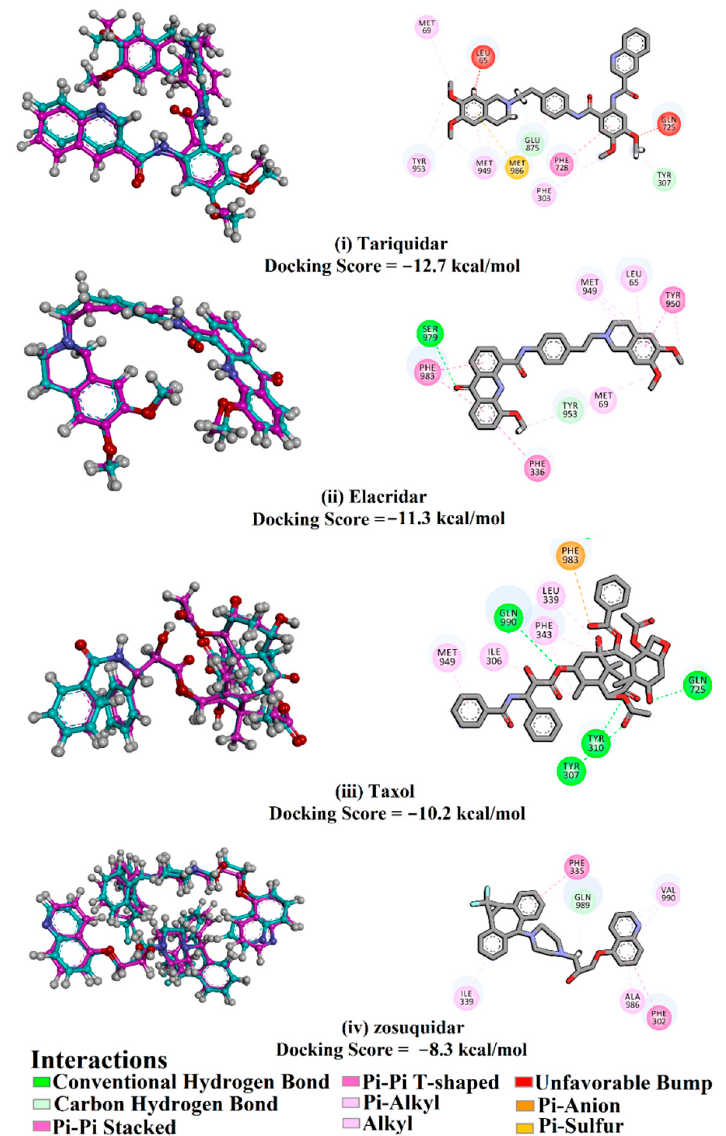
Figure 1. 3D and 2D molecular interactions of the experimental structures (in cyan) and the portended docking poses (in pink) of ( i ) tariquidar, ( ii ) elacridar, ( iii ) taxol, and ( iv ) zosuquidar in complex with ABCB1 transporter. The predicted docking scores are displayed in